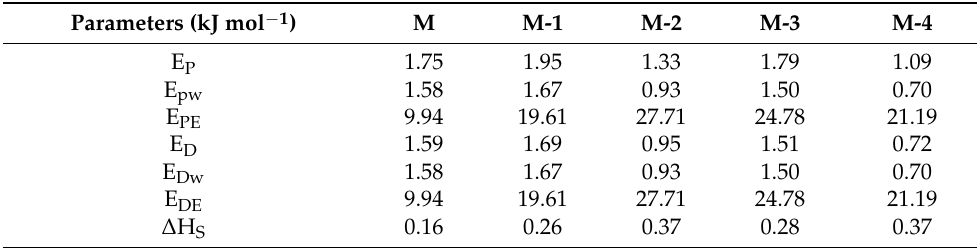
Table 8. Arrhenius activation parameter for permeation, diffusion, and heat of sorption in water– bioethanol